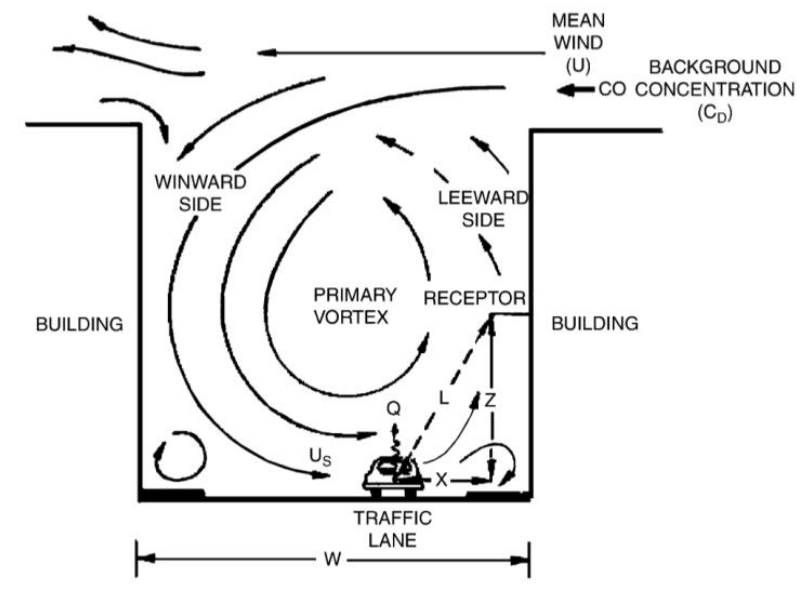
Figure 3. Cross-street dispersion circulation between buildings [27].